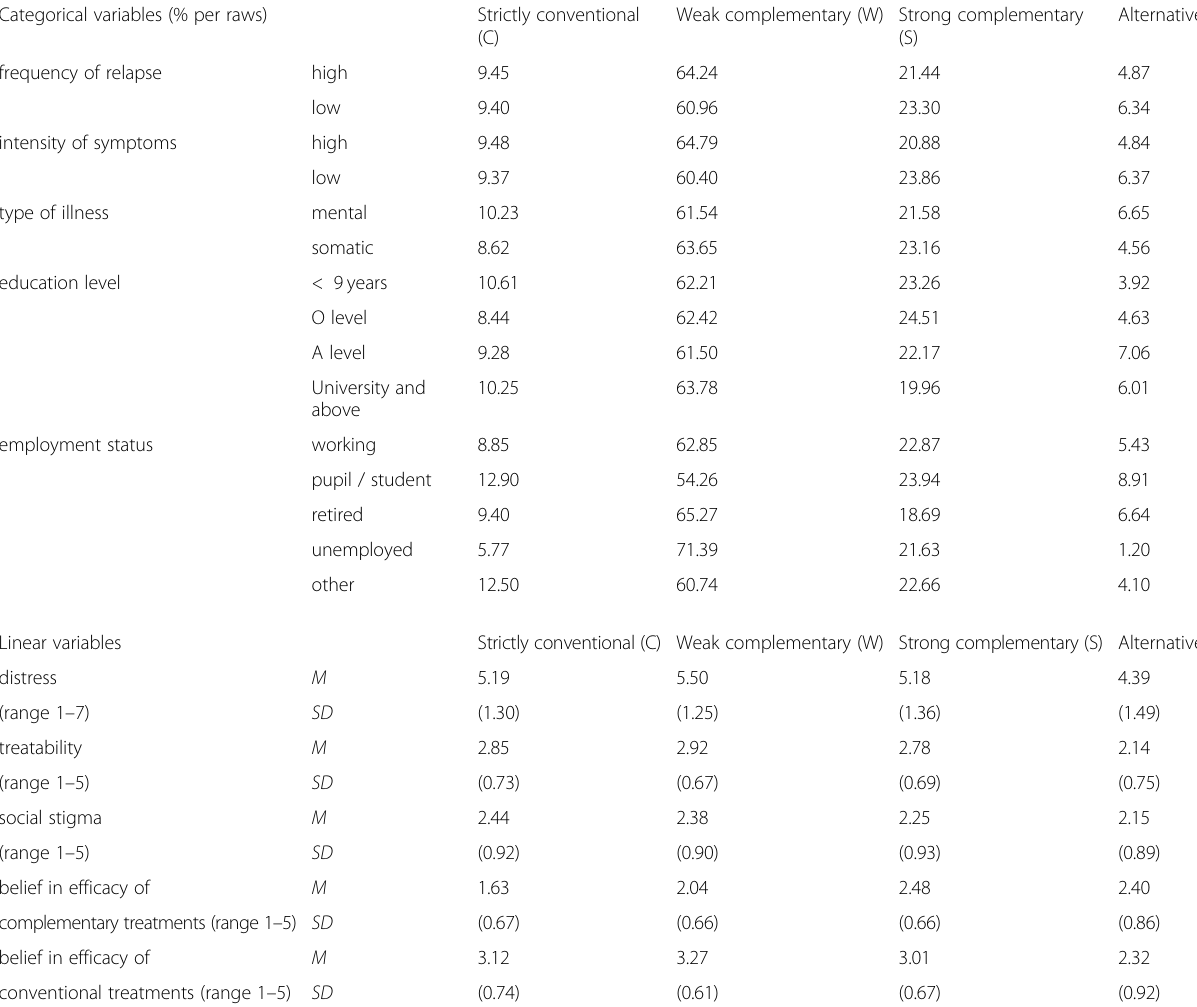
Table 4 Percentage of treatment options and rating scores associated with each treatment option Categorical variables (% per raws) Strictly conventional